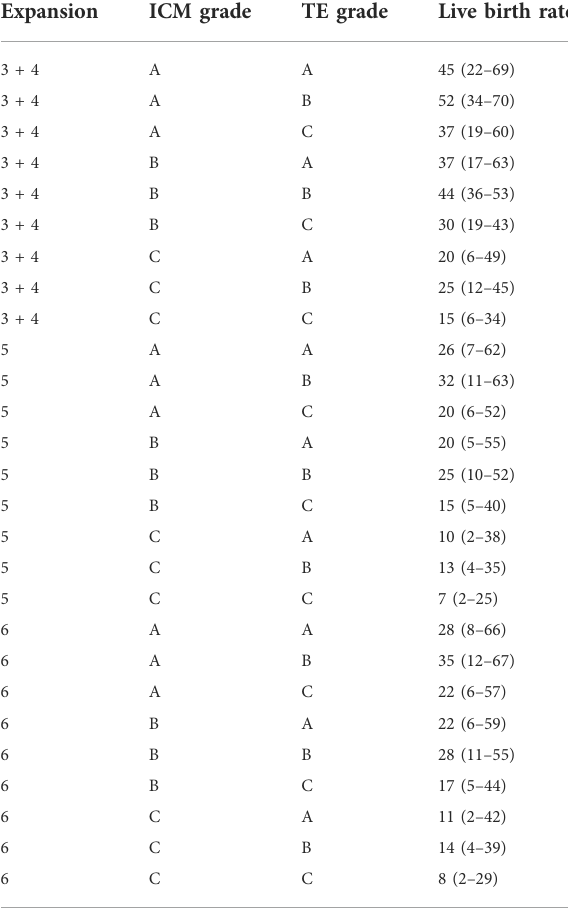
TABLE 4 Predicted live birth rate based on the multiple logistic regression model.